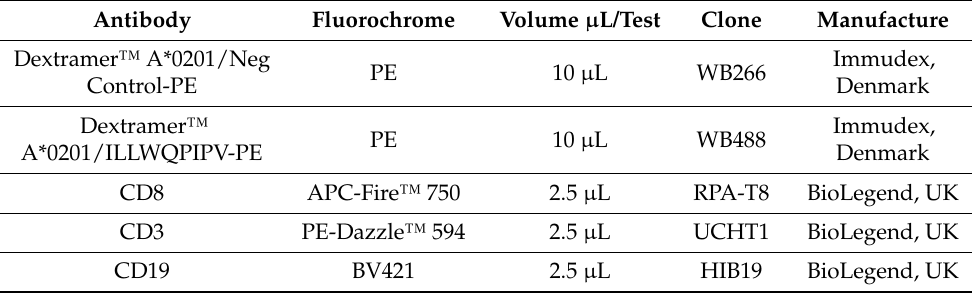
Table A2. Dextramers™ and human